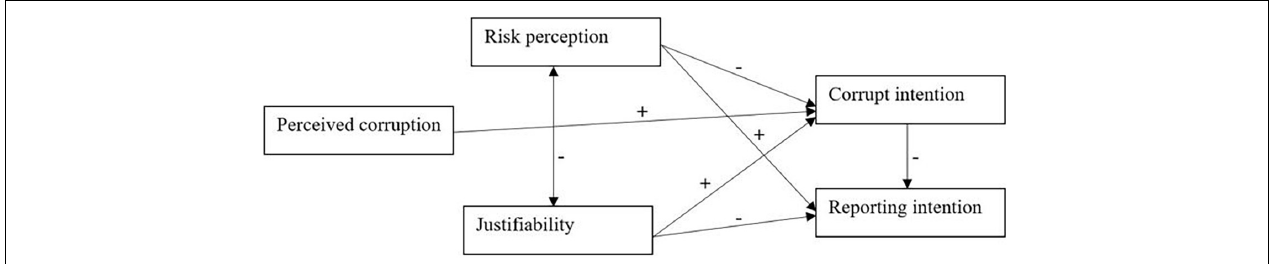
FIGURE 1 | Hypothesized